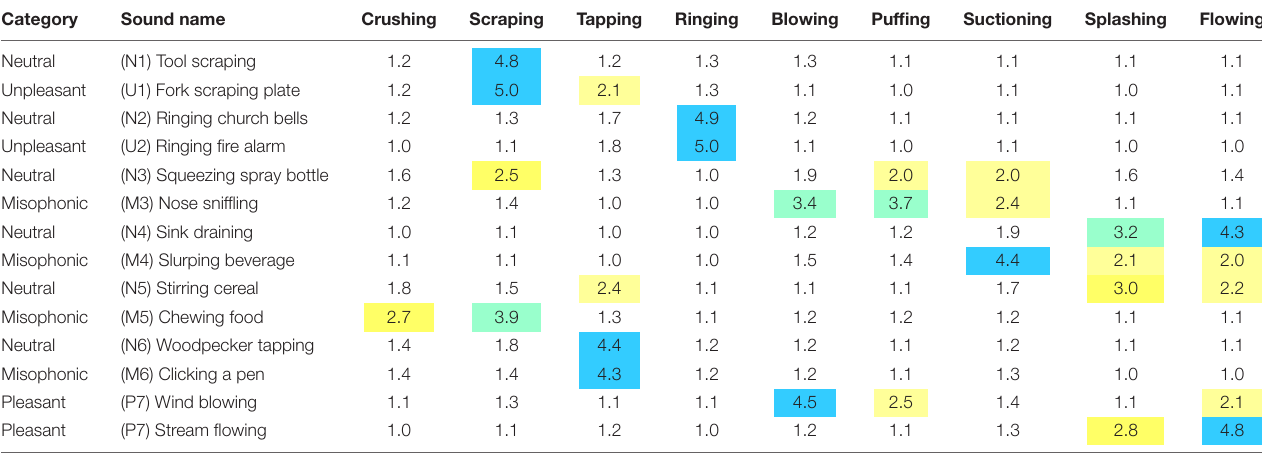
TABLE 3A | Mean causal action property ratings taken across all participants are indicated in each table entry, with rows corresponding to one of the fourteen sound tokens and columns corresponding to the nine causal actions. Category